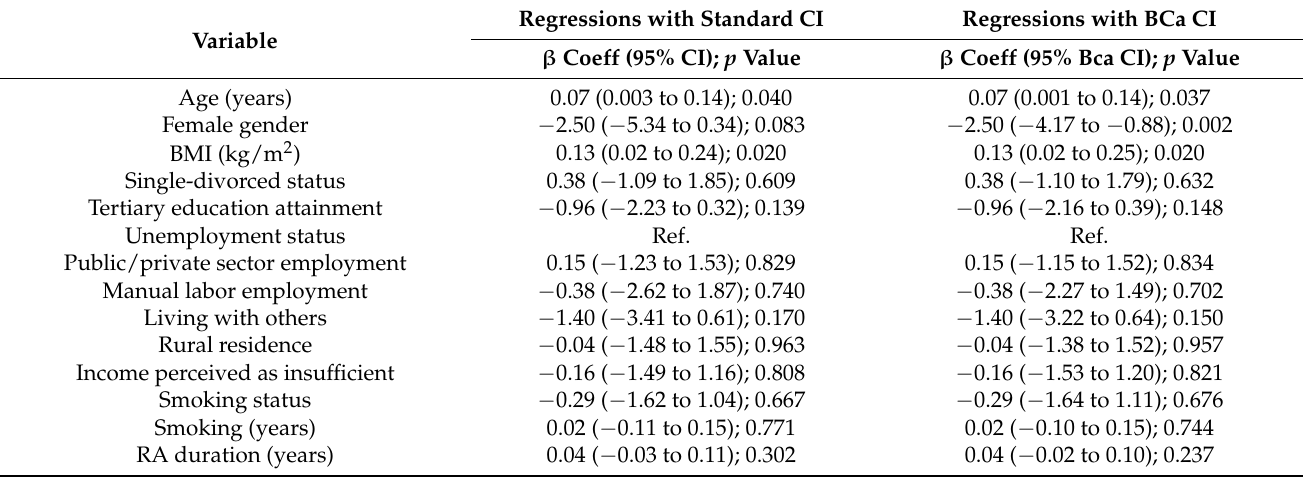
Table 4. Univariable linear regression associations of study variables with ORTO-15